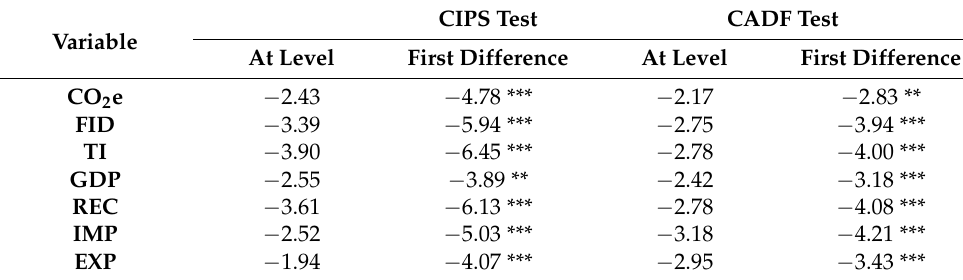
Table 6. CIPS and CADF unit root